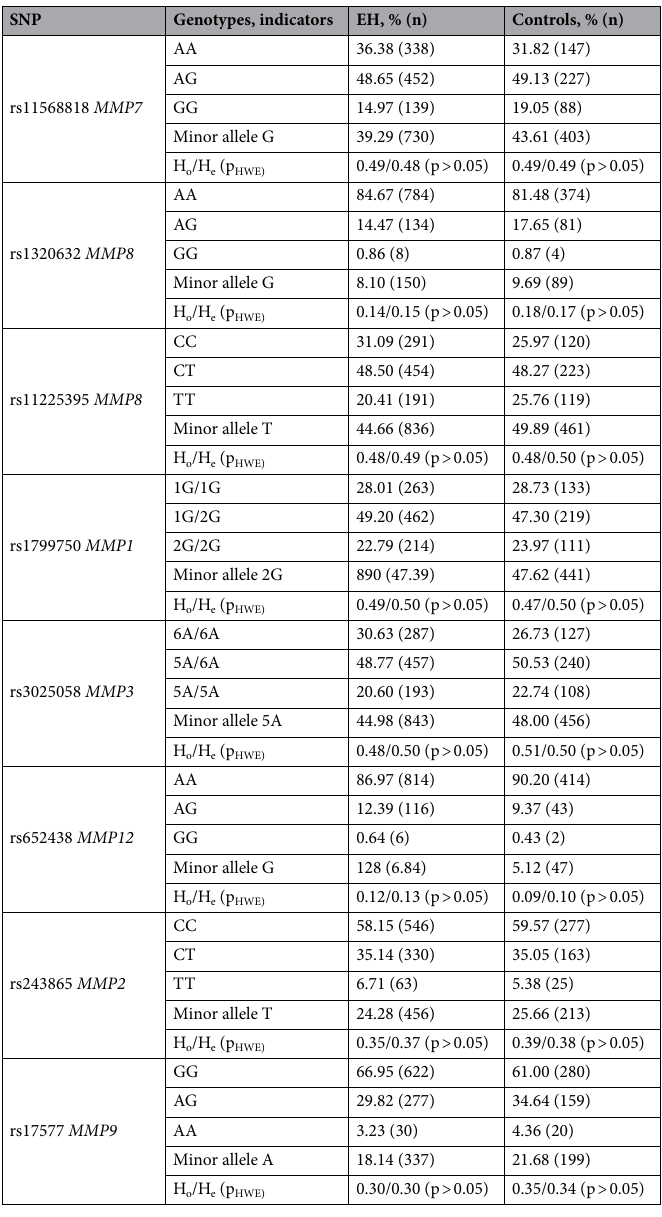
Table 2. The allele and genotype frequencies (%) of the studied SNPs in the EH and control groups. The number in the brackets represents the number of participants with the respective genotype (or